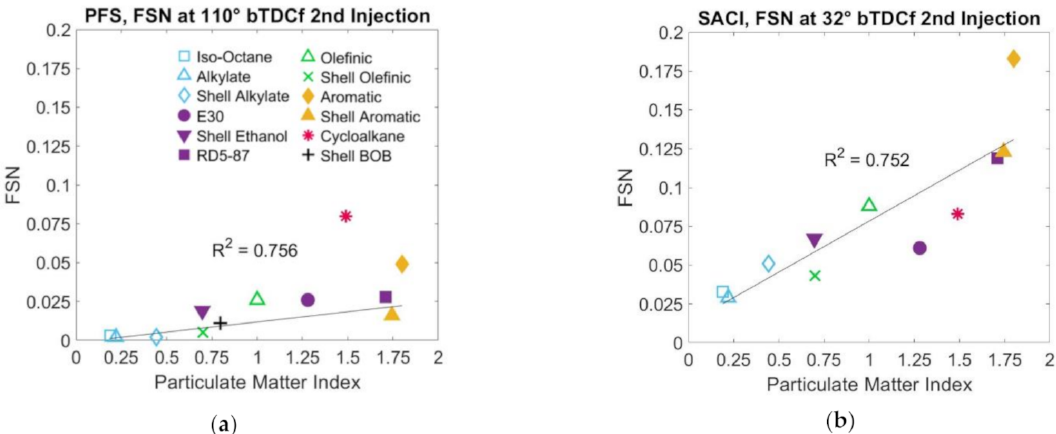
Figure 12. Smoke emissions, as measured by the filter smoke number (FSN) for ( a ) PFS and ( b ) SACI operation.